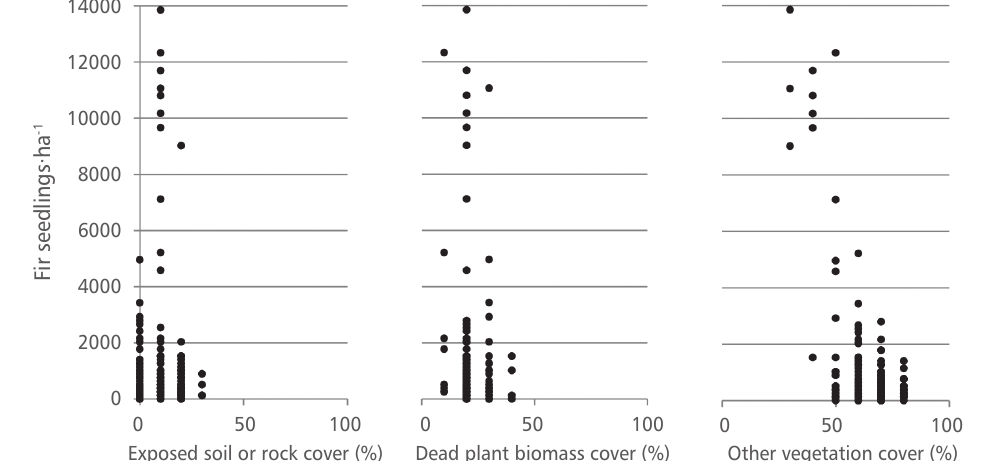
Exposed soil or rock cover FIGURE 5. Fir seedling densities observed at different levels of groundcover type (exposed soil or rock, dead plant biomass, other vegetation). Dots represent individual values.